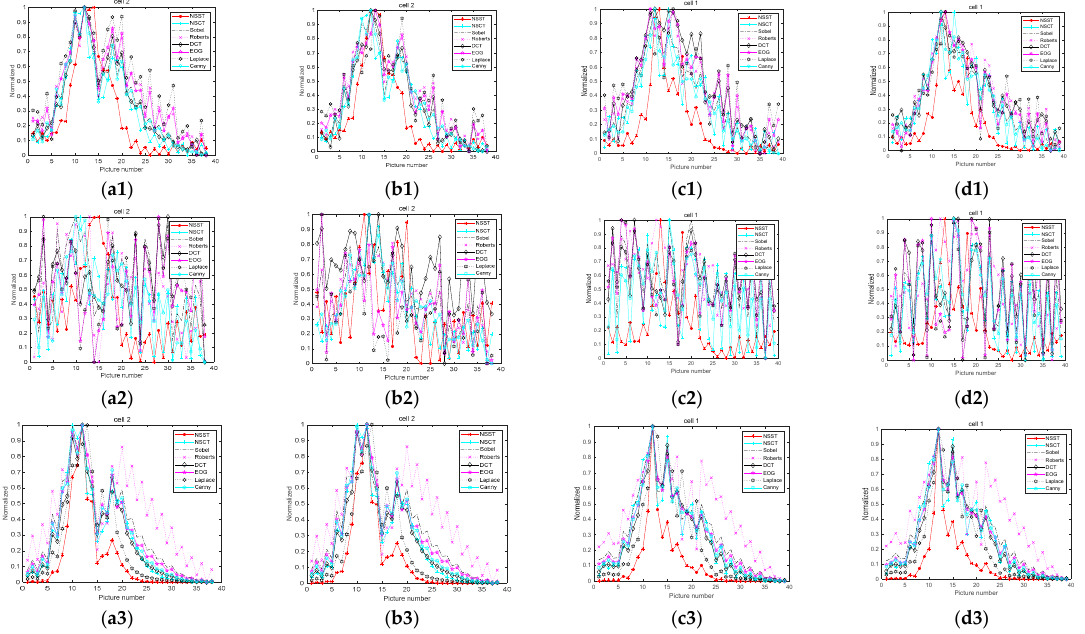
Figure 10. Curves after noises and filters are added: ( a1 ) Gaussian noise and bilateral filter of cell 2; ( b1 ) Gaussian noise and guided filter of cell 2; ( c1 ) Gaussian noise and bilateral filter of cell 1; ( d1 ) Gaussian noise and guided filter of cell 1; ( a2 ) salt-and-pepper noise and bilateral filter of cell 2; ( b2 ) salt-and-pepper noise and guided filter of cell 2; ( c2 ) salt-and-pepper noise and bilateral filter of cell 1; ( d2 ) salt-and-pepper noise and guided filter of cell 1; ( a3 ) Poisson noise and bilateral filter of cell 2; ( b3 ) Poisson noise and guided filter of cell 2; ( c3 ) Poisson noise and bilateral filter of cell 1; ( d3 ) Poisson noise and guided filter of cell 1.